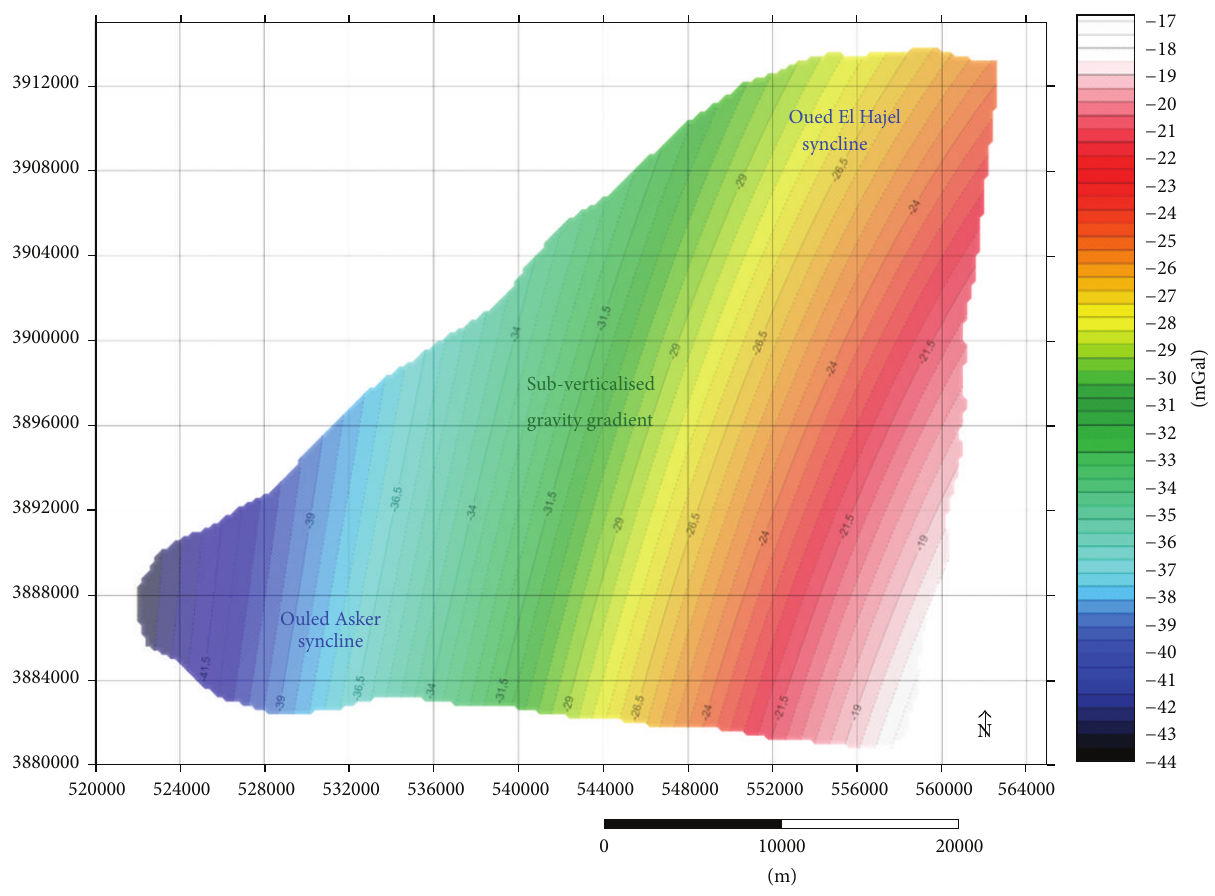
Figure 5: Regional gravity anomaly map of the study